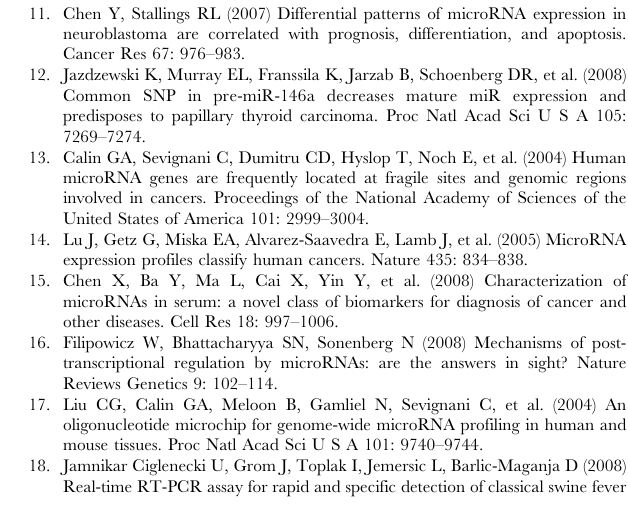
Figure S1 Funnel plots for the assessment of potential bias in miR-21